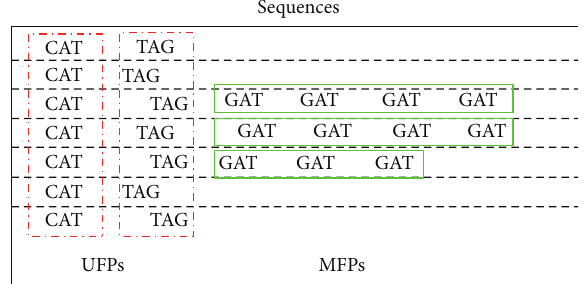
Figure 3: Tandem repeats of condons from the UFPs and